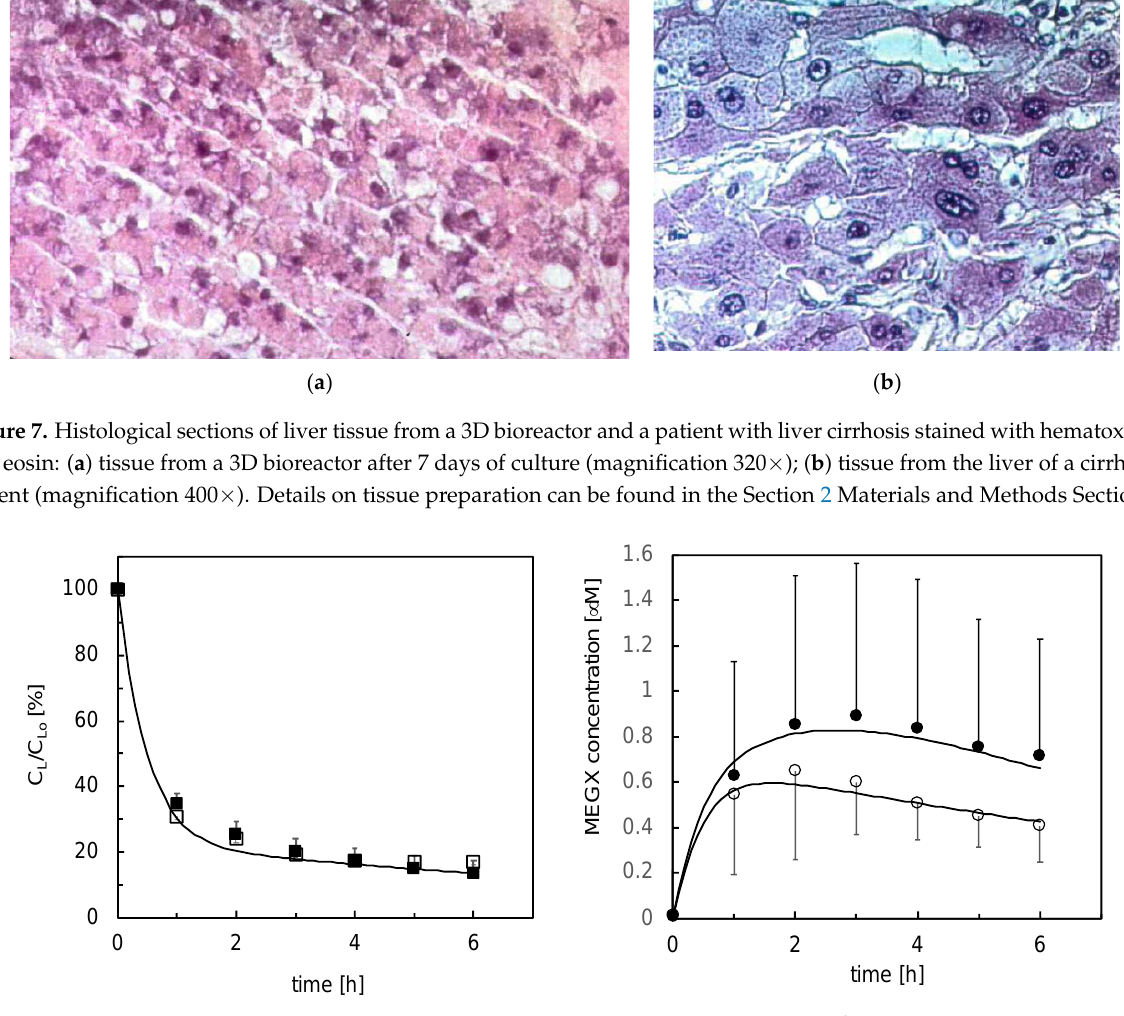
Figure 8. Metabolite concentration profiles in time during the kinetic tests with cell-seeded bioreactors ( n = 8) at different days of culture: lidocaine (( a ), ) and MEGX (( b ), ); open symbols — day 2; closed symbols — day 6. Lines are model predictions.